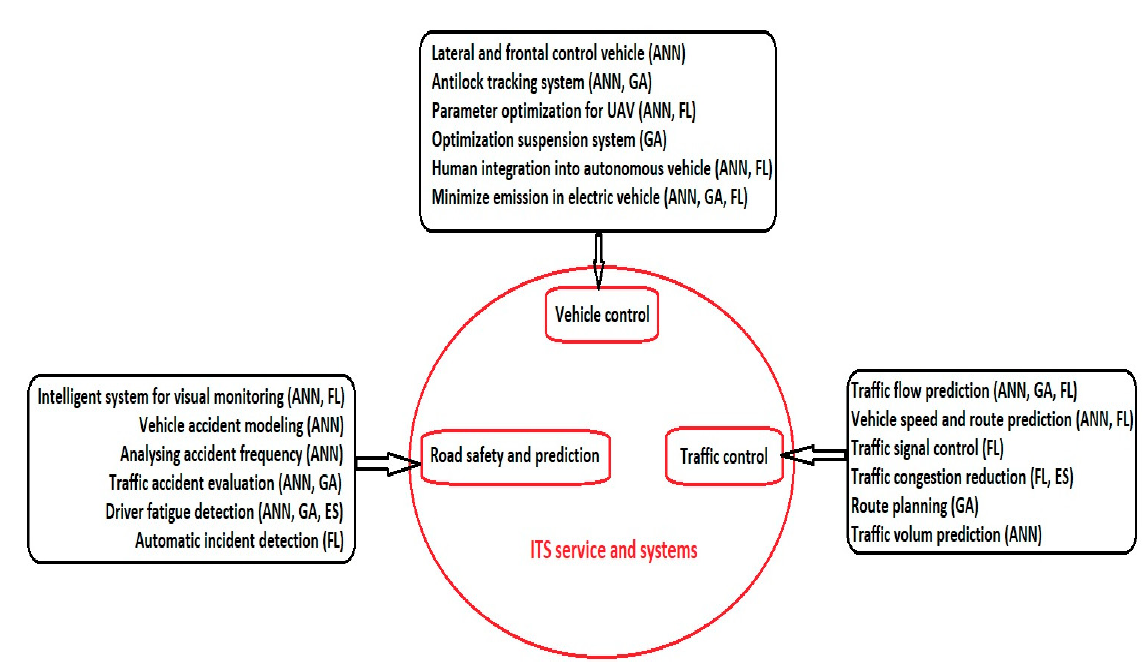
Figure 2. Chart of ITS systems and AI algorithms services.